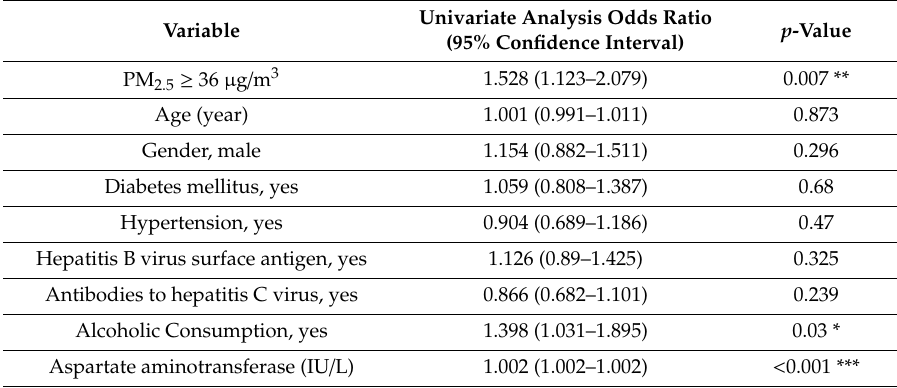
Table 3. Univariate Cox regression analysis of mortality ( N =